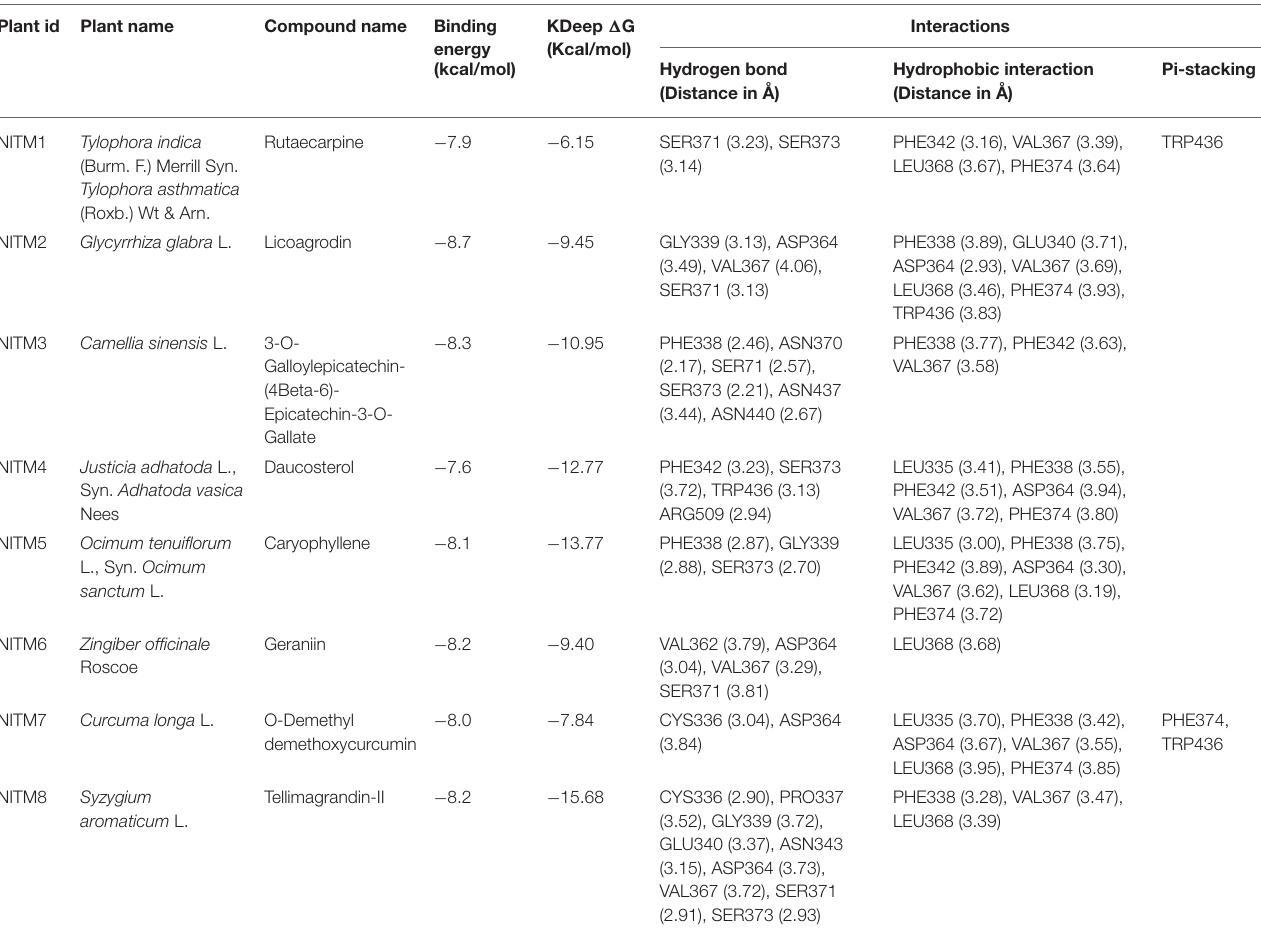
TABLE 1 | Compounds from each plant with best binding